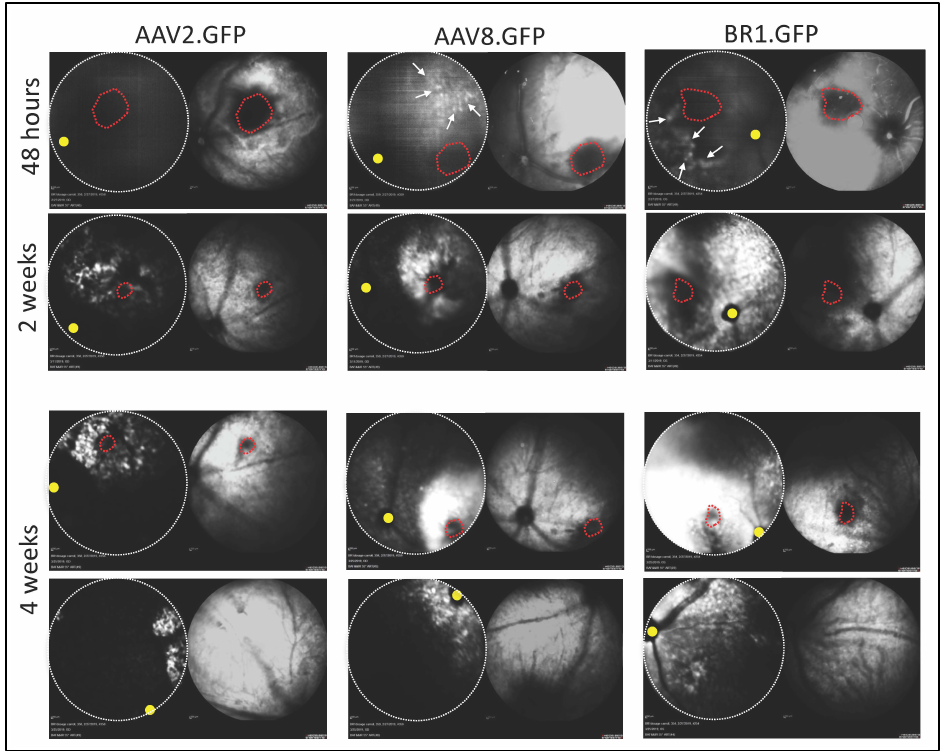
Figure 2. AAVBR1.GFP shows early and widespread expression in vivo following subretinal injection. Representative Spectralis images of three mouse retinas injected with either AAV2.GFP, AAV8.GFP, or AAVBR1.GFP (5 × 10 8 vg) and imaged at 48 h, 2 weeks, and 4 weeks. Left images show fundus GFP signal using short-wavelength autofluorescence (FA mode). Corresponding right infrared images confirm orientation. Dotted red line indicates injection site. Yellow dot indicates optic disk. By 48 h post-delivery, faint in vivo GFP signal is visible in both AAVBR1.GFP- and AAV8.GFP-injected retinas (indicated by arrows), whereas AAV2.AcGFP expression is undetectable at this early timepoint. Four weeks after injection, widespread expression of AAVBR1.GFP is seen both proximal ( second to bottom panels ) and distal ( bottom panels ) to the injection site, compared to limited lateral spread of GFP signal following AAV2 or AAV8 delivery.